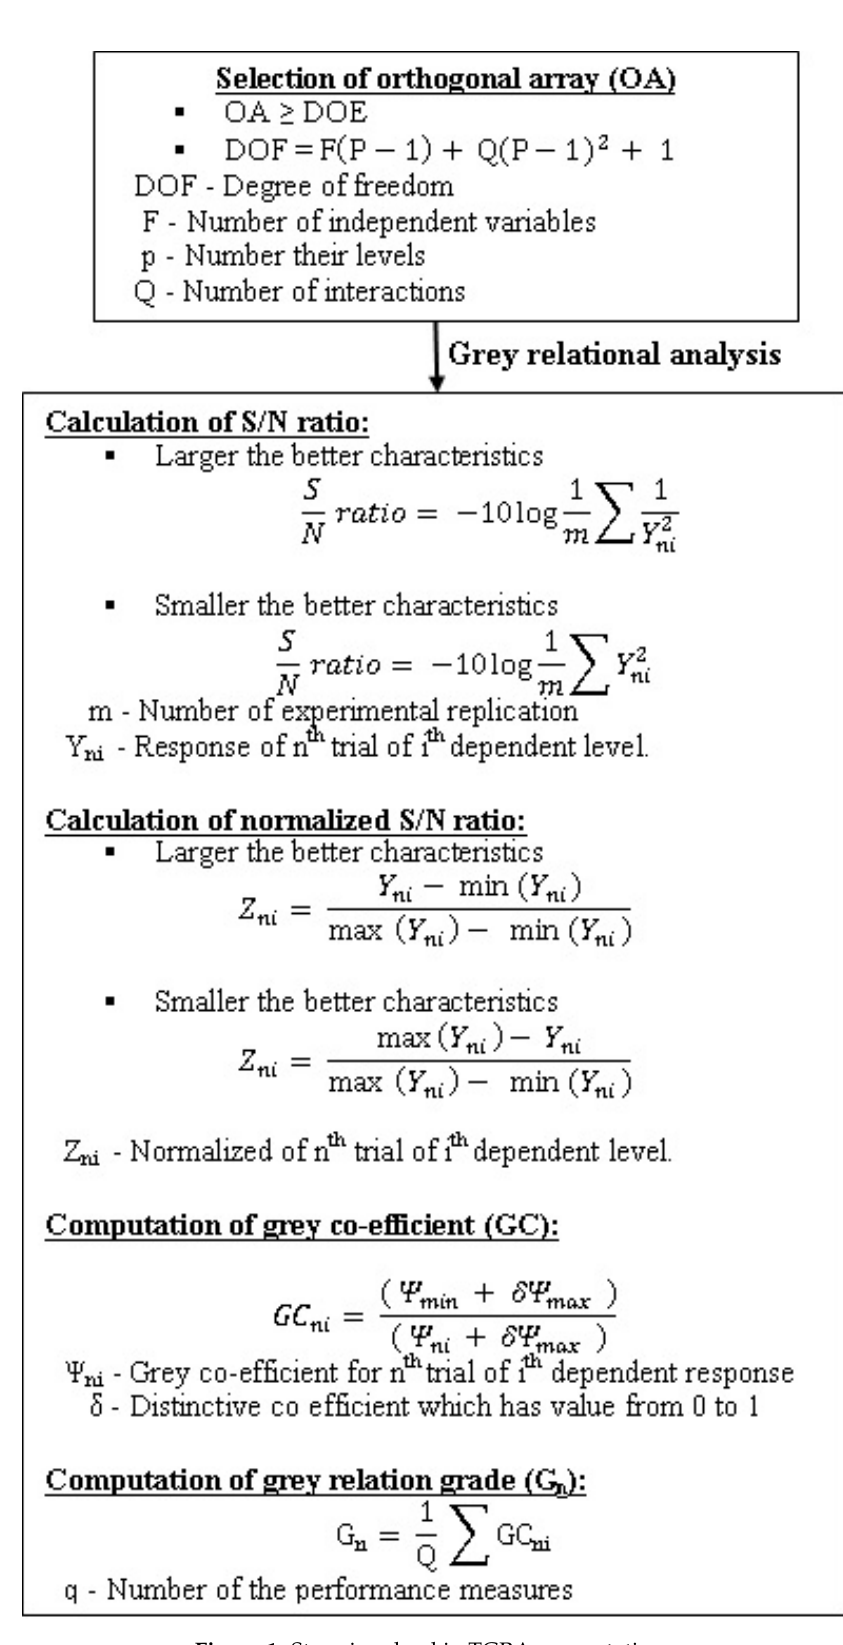
Figure 1. Steps involved in TGRA computation.